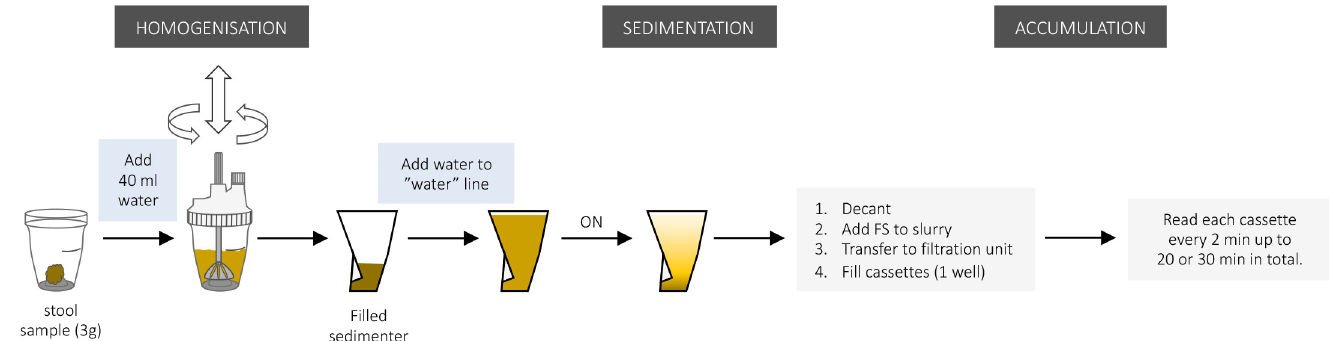
Fig 4. Schematic representation of the experiment designed to evaluate the optimal accumulation